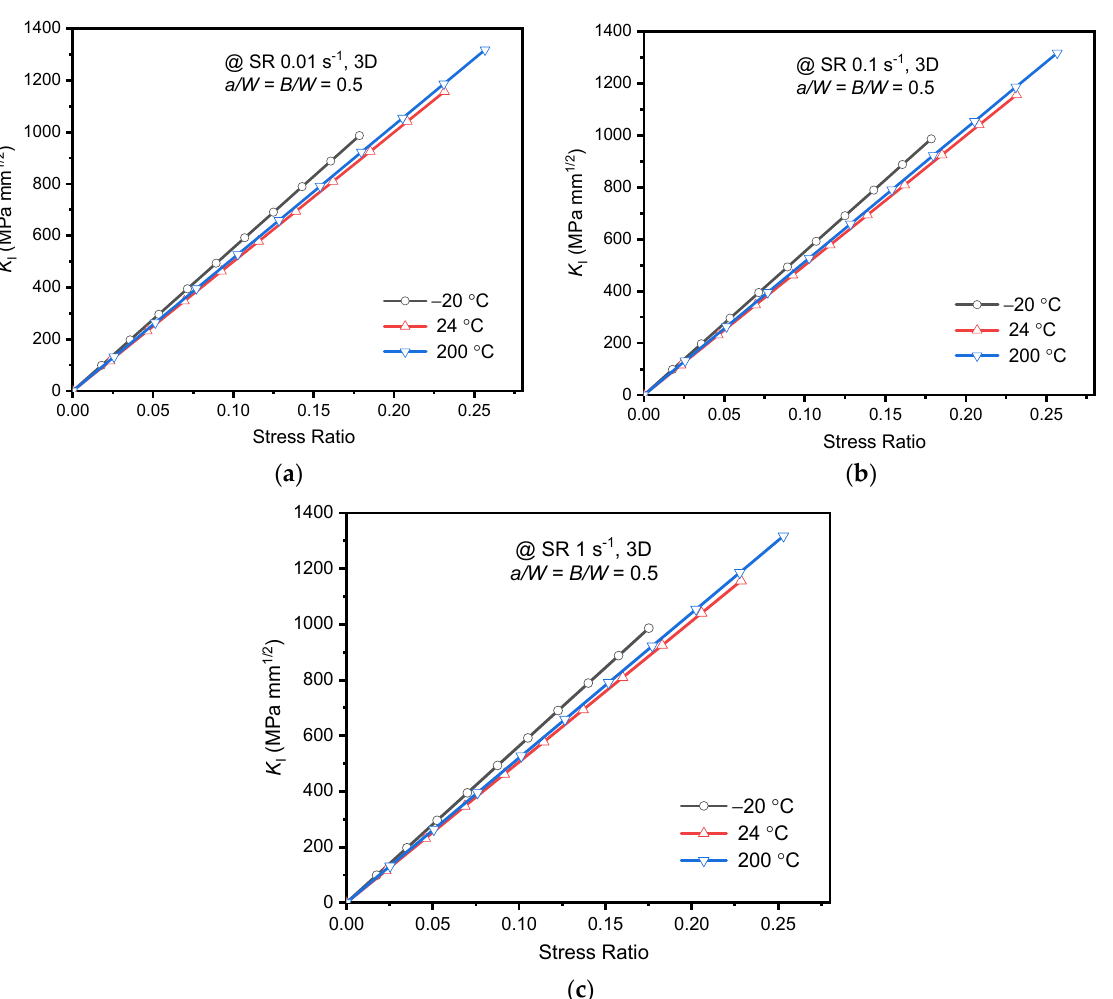
Figure 9. K I at specimen thickness center obtained using FEA for different temperature vs. Stress ratio ( a ) SR 0.01 s − 1 ; ( b ) SR 0.1 s − 1 ; ( c ) SR 1 s − 1 .